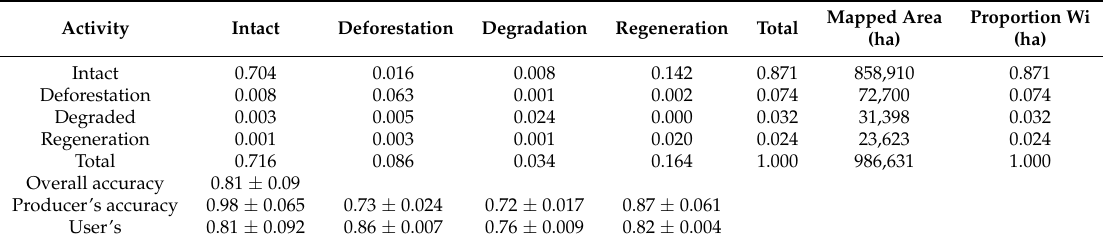
An error matrix showing accuracy of forest change between 2009 and 2011 with 95% confidence